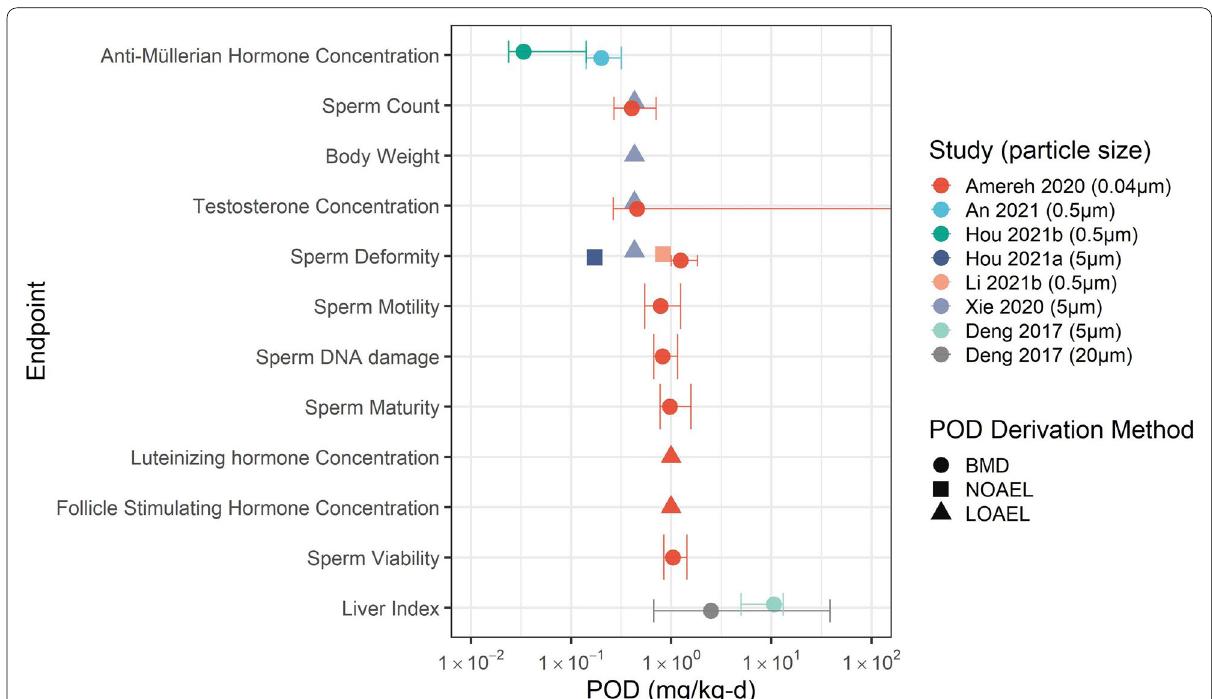
Fig. 4 Summary of BMD modelling output results for endpoints deemed reliable by outside experts. Points represent BMDs, and error bars represent 95% confidence intervals predicted by US EPA BMDS software